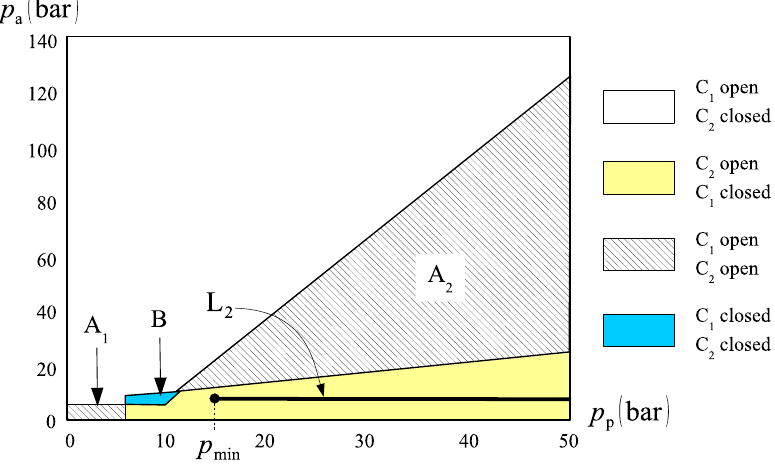
Figure 18. Operation zone shifting during first and fourth quadrants.